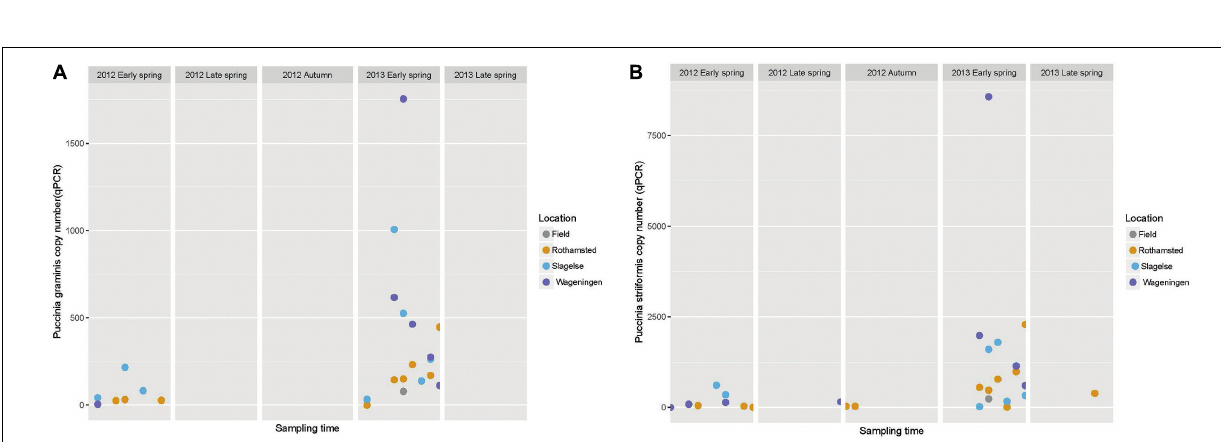
FIGURE 6 | Graph showing the abundance of Puccinia graminis and P. striiformis gene copy numbers quantified by qPCR in Rothamsted, Slagelse, and Wageningen during five periods in spring 2012 and 2013 and autumn 2012. Note that the graph does not represent a continuous sampling but five temporally separated periods. (A) P. graminis ; (B) P. striiformis